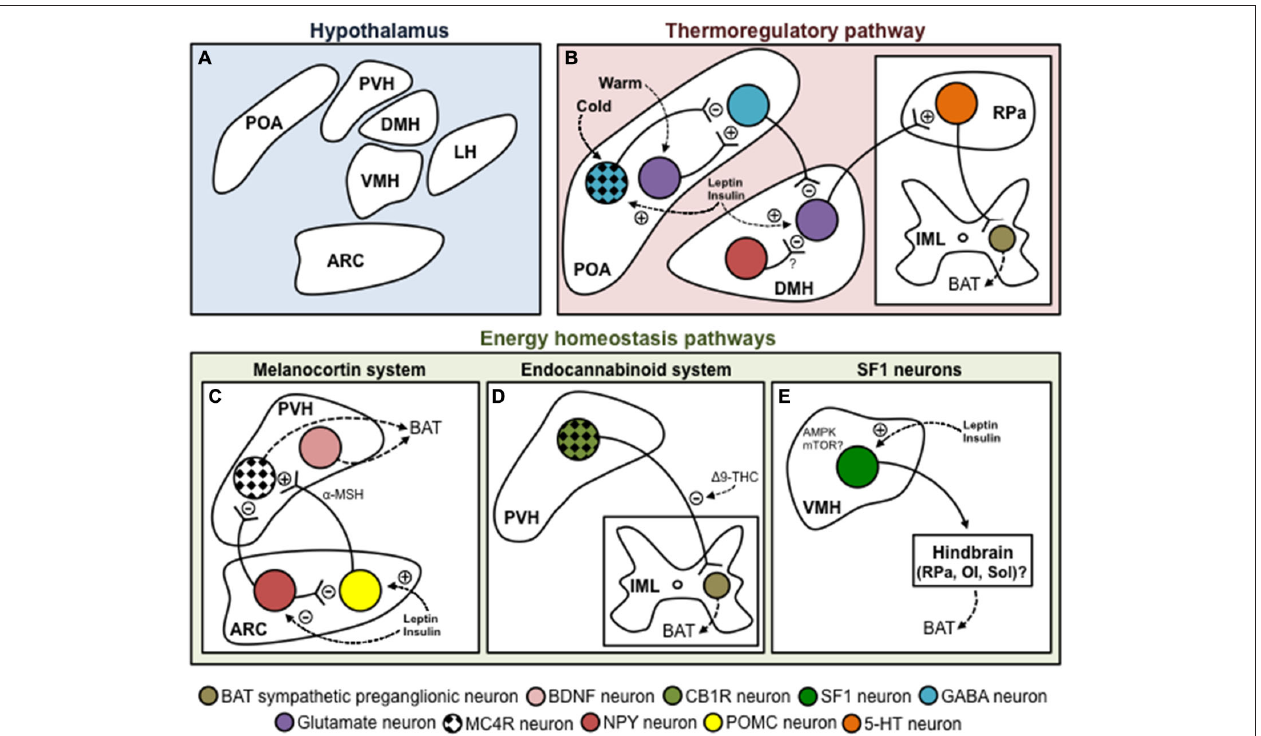
FIGURE 1 | Hypothalamic control of brown adipose tissue thermogenesis. (A) Schematic and tentative representation of the hypothalamic structures involved in the control of BAT thermogenesis. (B) POA is considered to be a major coordinator of thermoregulation as it receives inputs from thermoreceptors essentially located in the skin. Within the POA, cold appears to signal mainly through the MnPO, where GABAergic neurons inhibit GABAergic neurons of the MPO. On the other hand, warm activates glutamatergic neurons in the MnPO, which activate GABAergic neurons of the MPO. One important relay receiving inputs from the POA to regulate BAT metabolism is the DMH. The GABAergic neurons of the MPO provide a negative tonic inhibition toward glutametergic neurons located in the DMH. DMH neurons project to the rostral ventromedial medulla, apparently to the RPa, amain site of BAT SNS premotor neurons. NPY neurons of the DMH could apparently also negatively affect BAT thermogenesis, possibly by inhibiting glutamatergic neurons located in the DMH itself. There also exists at least three important energy homeostasis pathways for BAT thermogenesis. (C) The melanocortin system is a critical component for the maintenance of energy balance. In the ARC, NPY/AgRP neurons inhibit, while POMC neurons (through the production of α -MSH) activate MC4R neurons located in the PVH. These neurons stimulate BAT thermogenesis. However, their identity is actually unknown. Non-MC4R neurons expressing BDNF were also recently shown to regulate BAT metabolism. (D) The endocannabinoid system represents another important system regulating BAT thermogenesis. We have recently shown that injection of ∆ 9-THC into the fourth ventricle blunts the thermogenic effects of MTII injected in the PVH. This suggests that MC4R-CB1R neurons located in the PVH regulate BAT metabolism. (E) SF1 neurons of the VMH are also well known to affect BAT thermogenesis. Converging evidence indicates that both AMPK and mTOR signaling are molecularly involved in this fine regulation. The VMH neurons regulating thermogenesis seem to relay through hindbrain structures such as the RPa, OI or Sol. (C–E) It is noteworthy that in addition to interacting together, these hypothalamic systems regulating BAT thermogenesis are modulated by important homeostatic hormones such as leptin and insulin. Abbreviations: 5-HT, serotonine; α -MSH, α -melanocyte-stimulating hormone; ∆ 9-THC, ∆ 9-tetrahydrocannabinol; AMPK, AMP-activated protein kinase; ARC, arcuate nucleus; BAT, brown adipose tissue; BDNF, brain-derived neurotrophic factor; CB1R, cannabinoid receptor type 1; DMH, dorsomedial hypothalamus, GABA, gamma-aminobutyric acid; IML, intermediolateral nucleus; LH, lateral hypothalamus; MC4R, melanocortin receptor 4; MnPO, median preoptic area; MPO, medial preoptic area; MTII, melanotan II; mTOR, mechanistic target of rapamycin; NPY, neuropeptide Y; OI, inferior olive; POA, preoptic area; POMC, proopiomelanocortin; PVH, paraventricular hypothalamus; RPa, raphe pallidus; SF1, steroidogenic factor 1; Sol, nucleus of the solitary tract; VMH, ventromedial